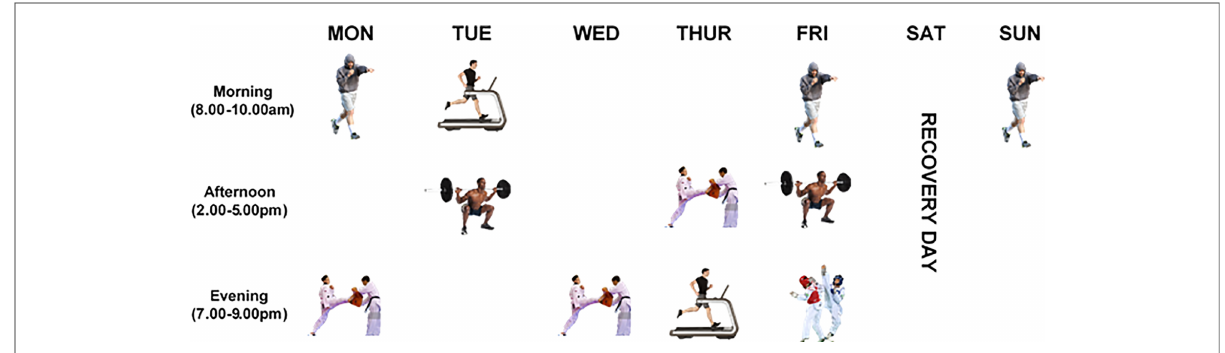
FIGURE 1 Weekly training schedule during phase 1 ( − 8 WK to − 4 WK) & phase 2 ( − 4 WK to − 1 WK). Training consisted on average of 3×60 min aerobic running (Monday, Friday & Sunday), 2×30 min high intensity interval treadmill running (Tuesday & Thursday), 2×60 min strength and conditioning (Tuesday & Friday), 3×120 min taekwondo speci fi c technical/tactical (Monday, Wednesday & Thursday) and 1×120 min sparring (Friday) based